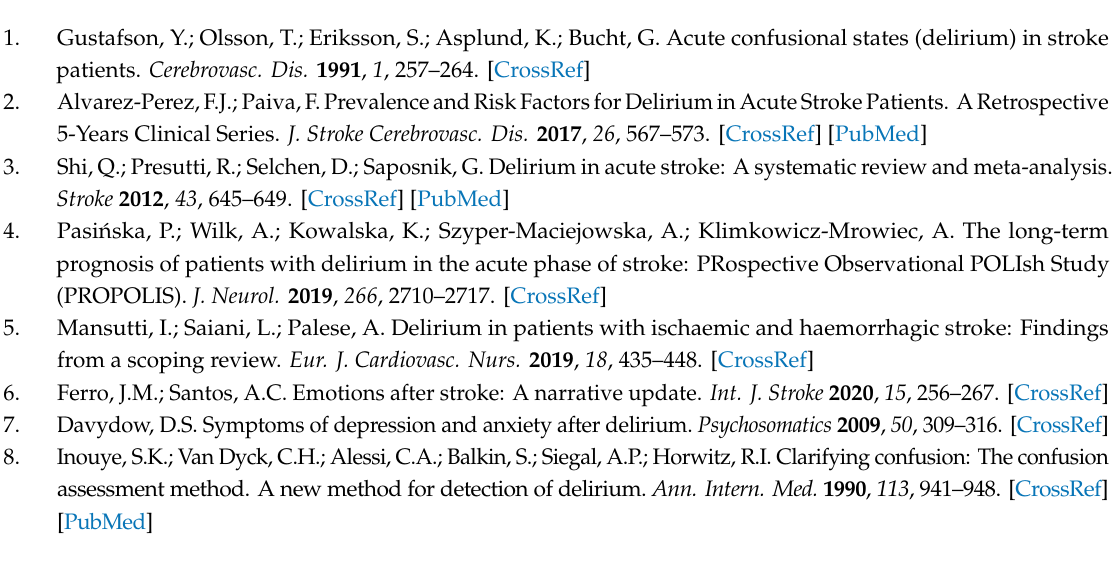
Table S1: Prevalence of depression, apathy, anxiety and aggression / hostility in hospital, at 3-month follow-up and 12-month follow-up in no-delirium and delirium groups, Table S2: Influence of post-stroke delirium on the incidence of depression in hospital, at 3-month follow-up and 12-month follow-up in univariate and multivariate logistic regression models, Table S3: Influence of post-stroke delirium on the incidence of apathy in hospital, at 3-month follow-up and 12-month follow-up in univariate and multivariate logistic regression models, Table S4: Influence of post-stroke delirium on the incidence of anxiety in hospital, at 3-month follow-up and 12-month follow-up in univariate and multivariate logistic regression models, Table S5: Influence of post-stroke delirium on the incidence of aggression / hostility in hospital, at 3-month follow-up and 12-month follow-up in univariate and multivariate logistic regression models, Table S6: Influence of post-stroke delirium on the incidence of depression, apathy, anxiety and aggression / hostility in hospital, at 3-month follow-up and 12-month follow-up in univariate and multivariate logistic regression